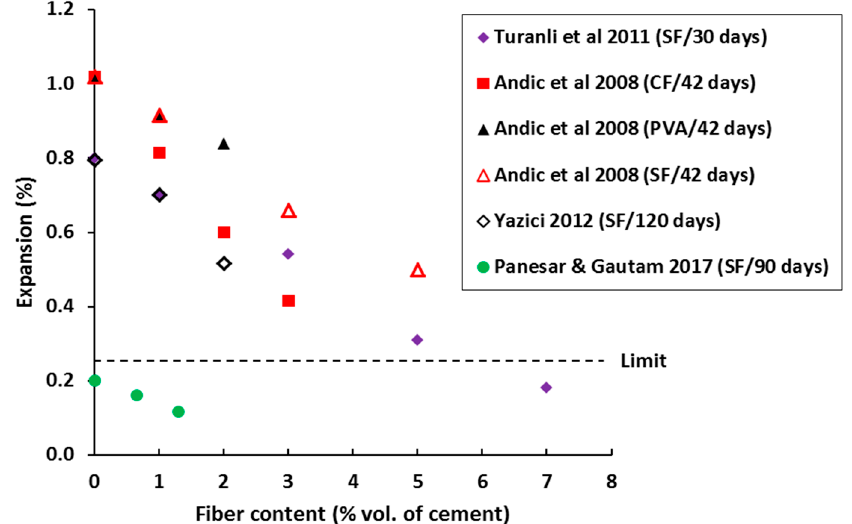
Figure 4. ASR expansion in FRC measured at different days for different fiber types and content (note: SF, CF and PVA means steel fiber, carbon fiber and PVA fibers) [88,93,95,96]. Materials 2020 , 13 , x FOR PEER REVIEW